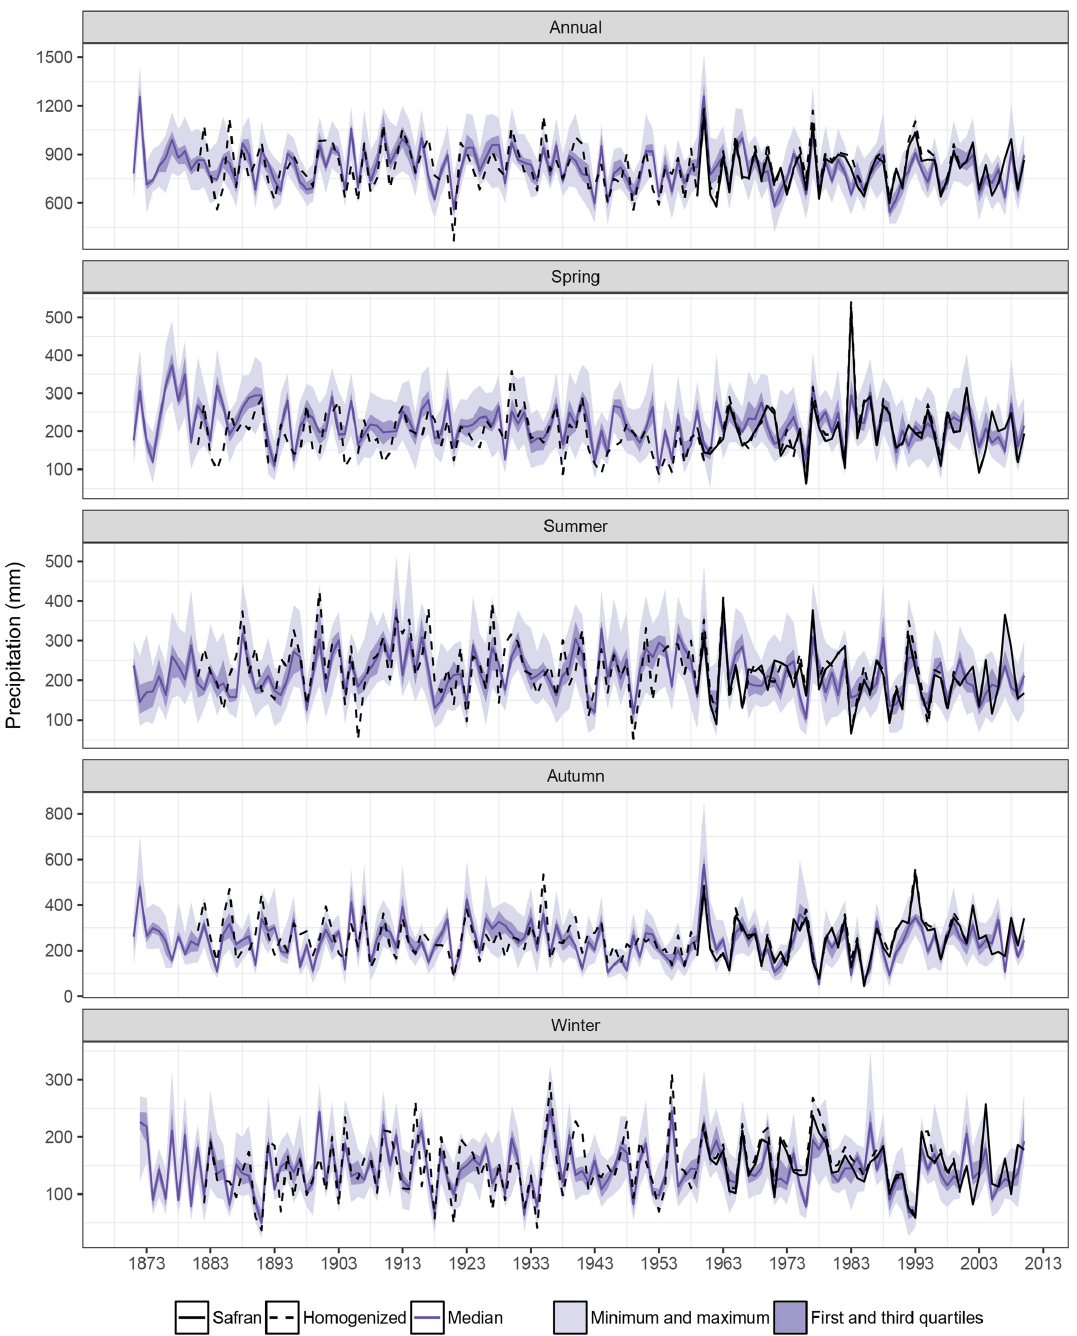
Figure 5. Lyon–Bron precipitation homogenized time series, corresponding Safran data, and reconstructed series from SCOPE Climate on the annual and seasonal timescales over the 1871–2012 time period. Light and dark purple areas define the range and the interquartile range, respectively, of values from SCOPE Climate members. Note the different scales for the y